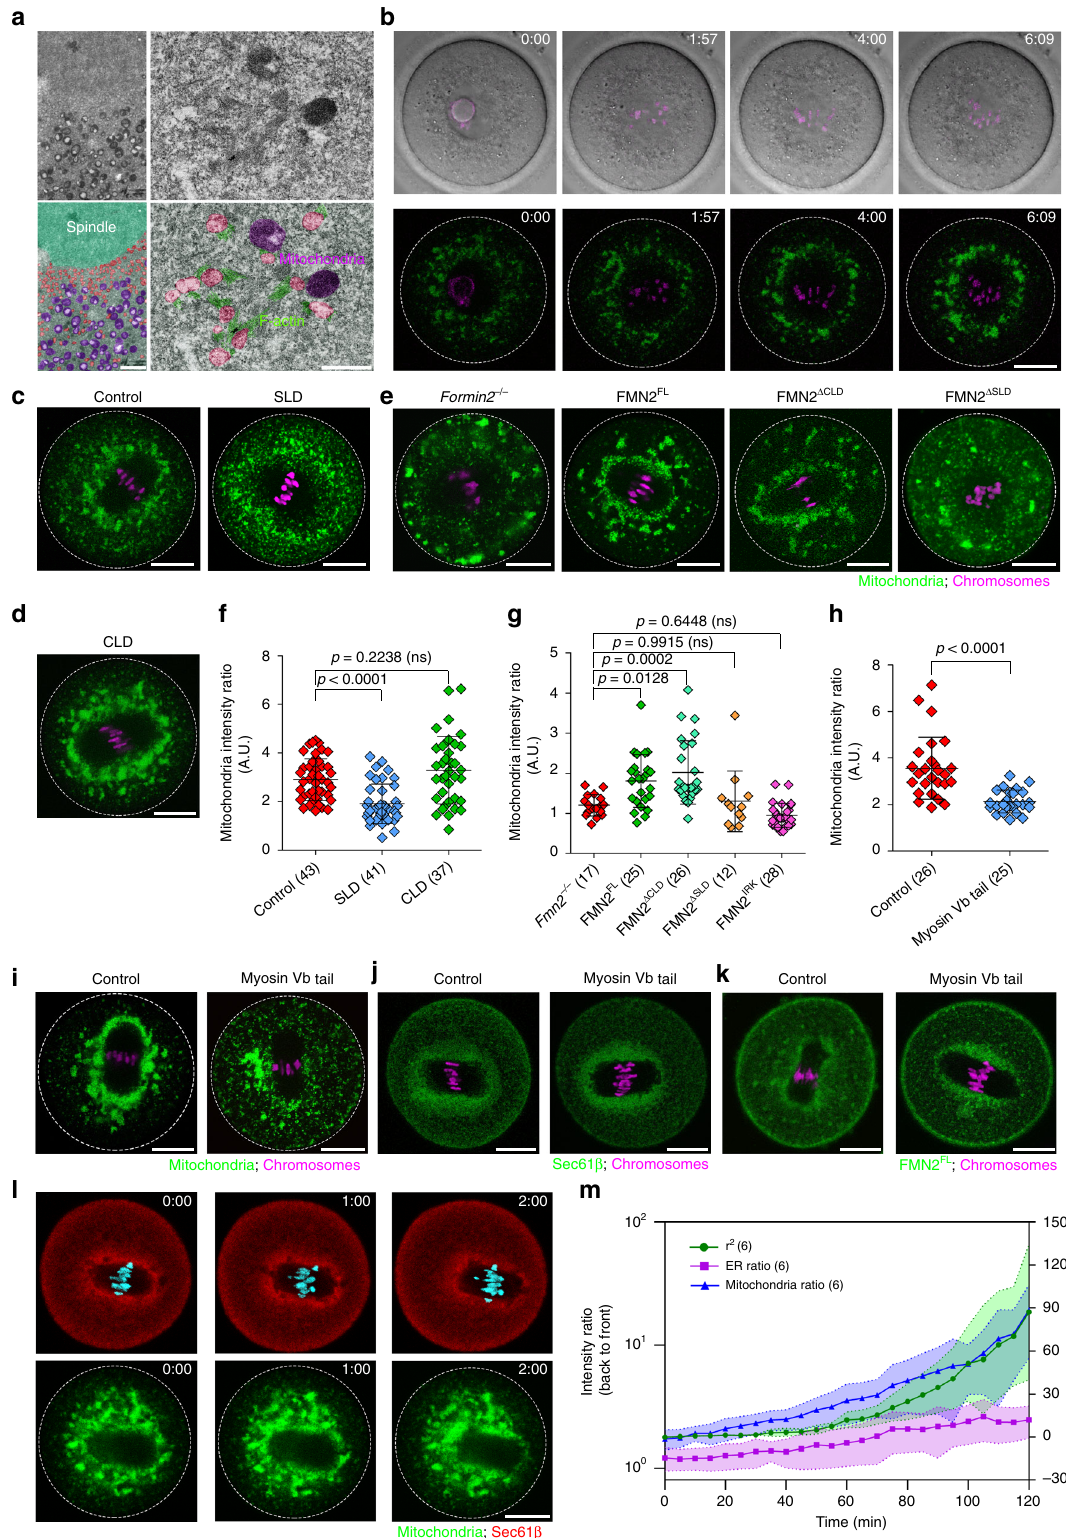
distributed around the spindle (Fig. 4e). The distribution of mitochondria gradually becomes asymmetric (Fig. 4f), and soon after, spindle translocation initiates with the leading end of the spindle surrounded by fewer mitochondria than the lagging end (Fig. 4g, Supplementary Fig. 5b, and Supplementary Movie 10).